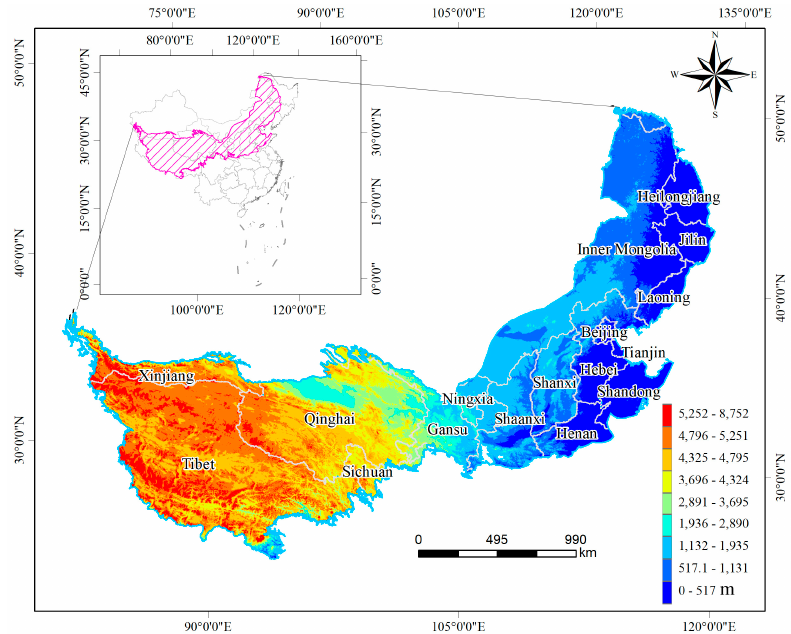
Figure 1. The geographical location of the 400 mm annual precipitation fluctuation zone and digital elevation model.